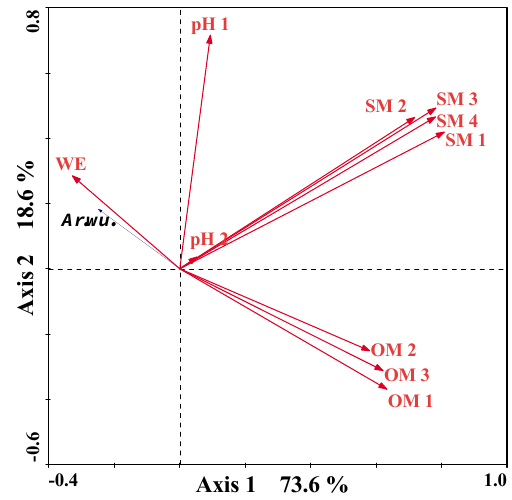
Figure 4. Redundancy analysis (RDA) of the relationship between asexual reproduction of A. wudanica (i.e. ramet density) and the field and environmental factors. The amount of variability explained by all the canonical axes was 92.2% ( F = 2.864, p = 0.0080). Ab- breviations for the study variables are given in Table